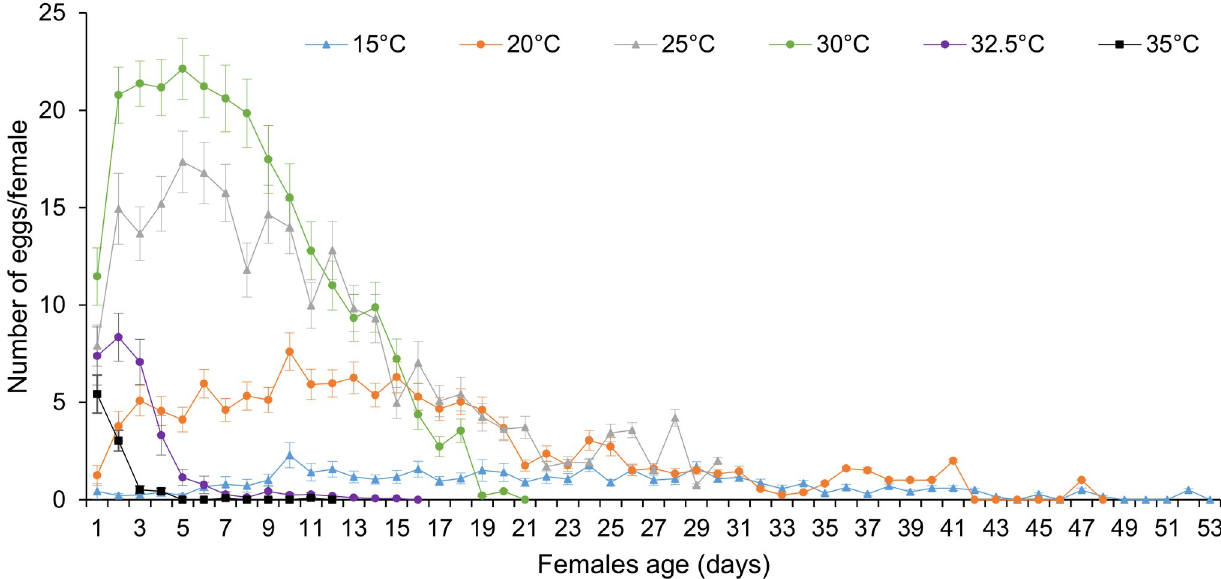
Fig 3. Number of eggs produced per female at different temperatures.